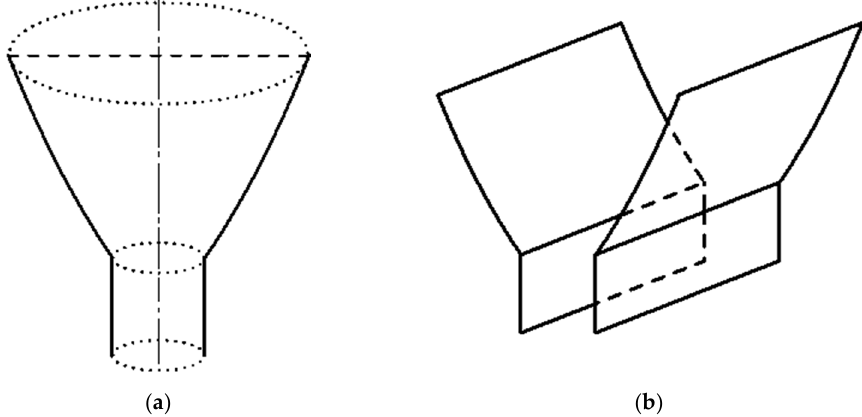
Figure A2. ( a ) 3D structure diagram of concentrator; ( b ) 2D structure diagram of concentrator.